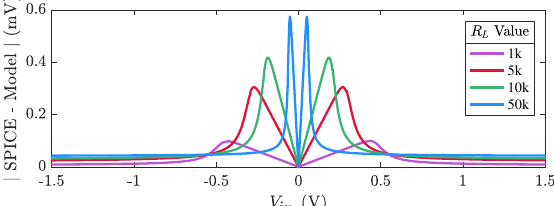
Figure 3. Absolute value of the difference between a SPICE simulation of the Lockhart wavefolder and its proposed VA model.